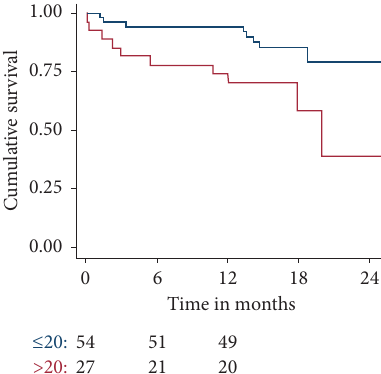
Figure 1: Cumulative survival of patients with Logistic Euro- SCORE I (ES) > 20 vs. ≤ 20% patients with ES > 20% had a worse outcome. ES > 20% was a significant predictor of mortality ( p �